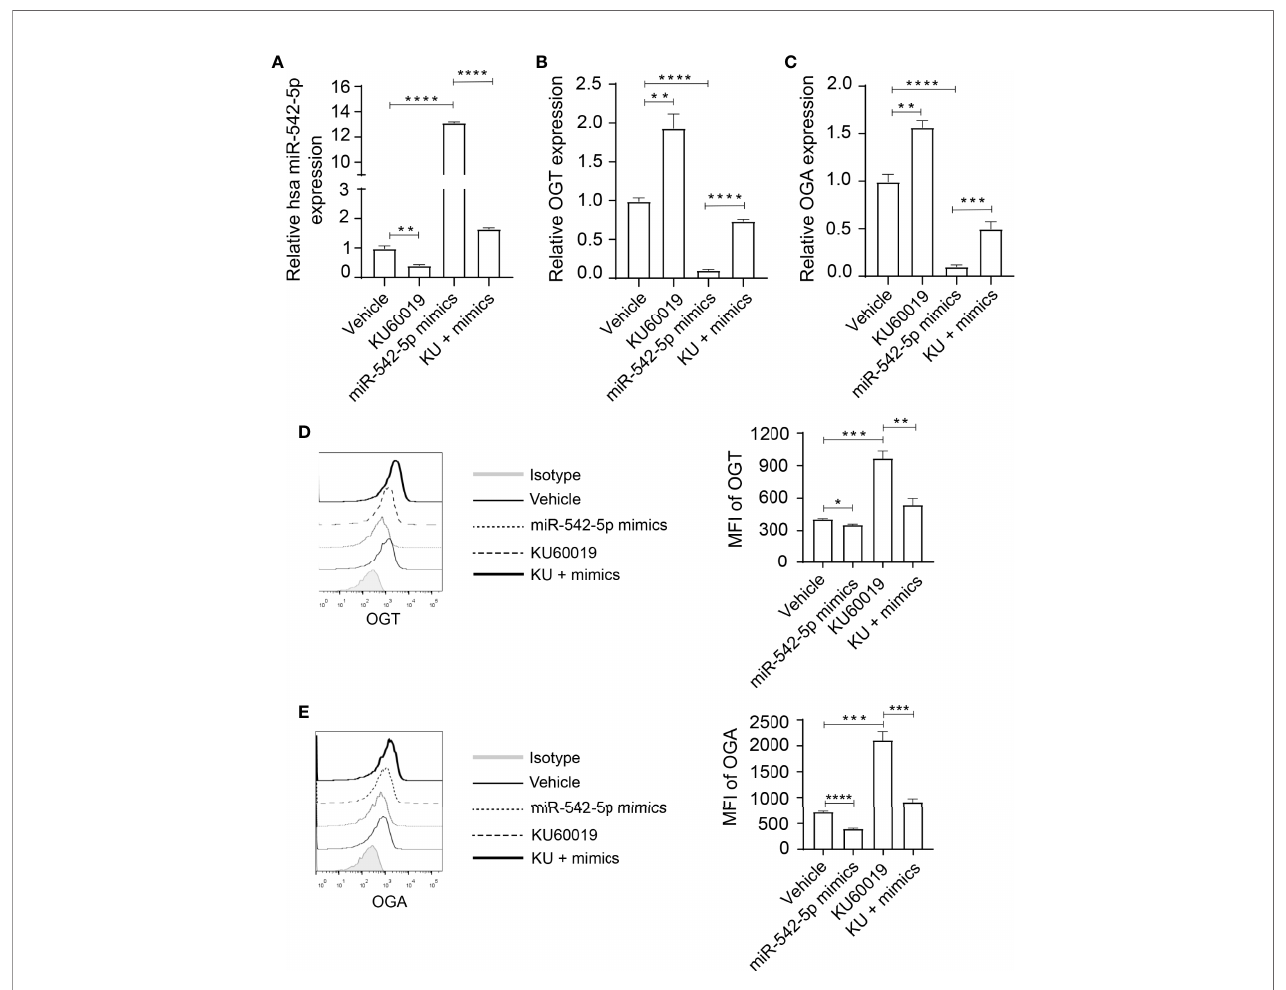
FIGURE 3 | Elevated miR-542-5p suppressed OGT and OGA expression in SK0V3 cells. SKOV3 cells were cultured in 6 well plates and treated with vehicle, or KU60019 (10 m M) for 24 h. Then cells were collected and qPCR or fl ow cytometry analysis of miR-542-5p (A) , OGT (B, D) , and OGA (C, E) in SKOV3 cells. *P< 0.05; **P< 0.01; ***P<0.001; ****P < 0.0001. Data are representative of three independent experiments with similar results. Quanti fi cation of signal was shown in bar graphs and error bars represent mean ±